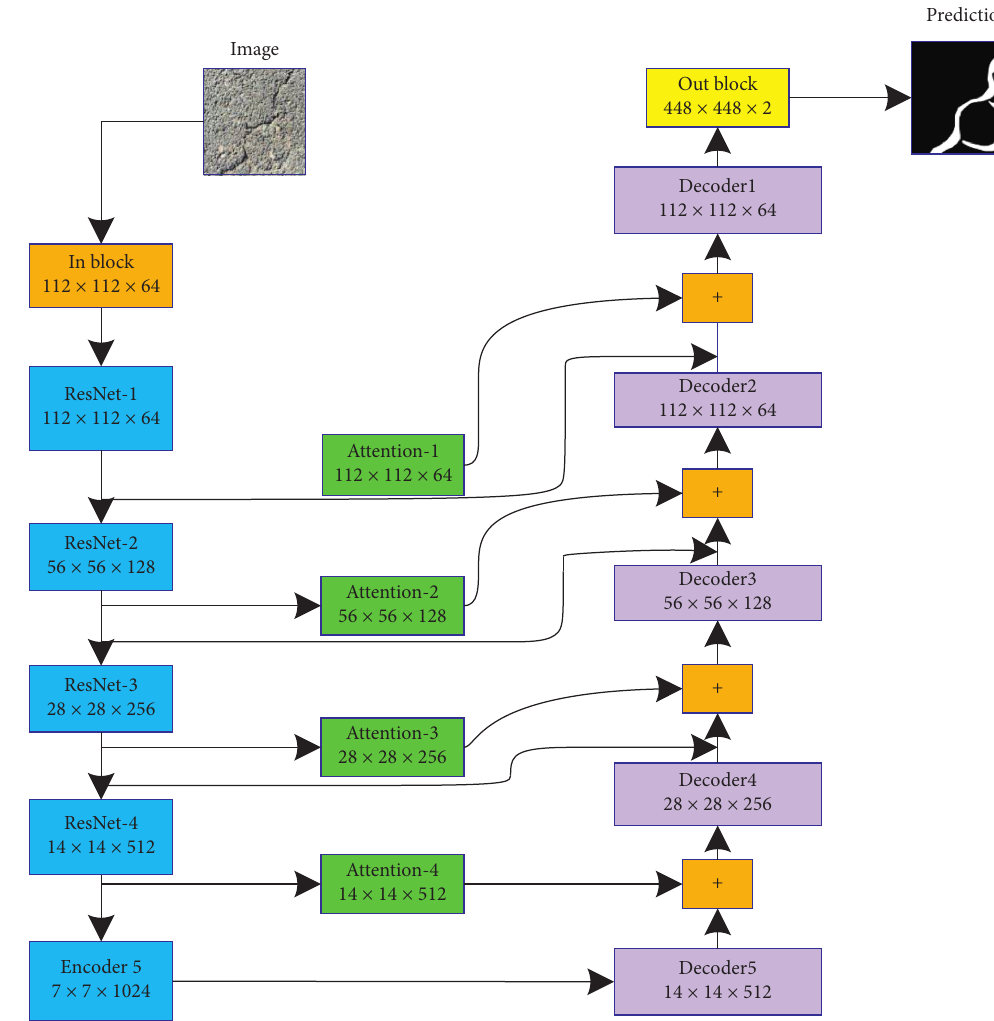
Figure 2: An illustration of the CrackResAttentionNet